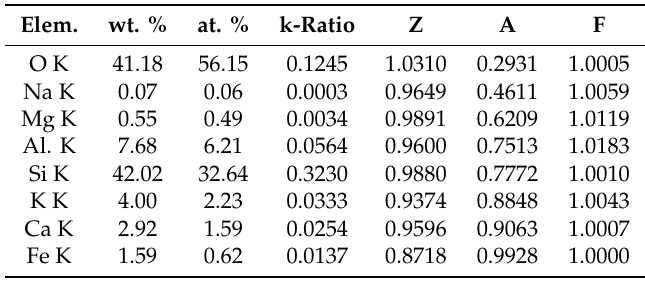
Table 5. Framework composition of the investigated AC 16 asphalt